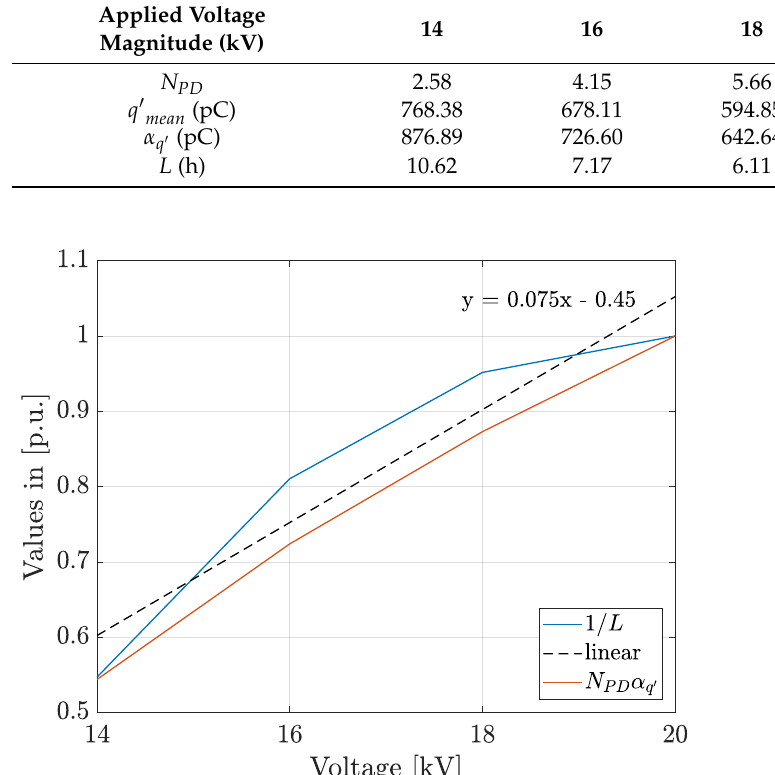
Figure 6. Comparison of the accumulated damage and the ageing rate function, N PD α q’ , for different voltage magnitudes.